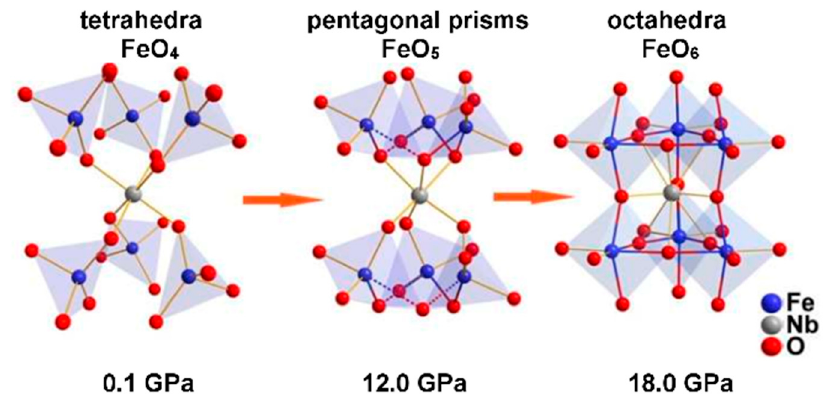
Figure 9. Structural fragments from Fe-O polyhedra of polymorph modifications of Ba 3 NbFe 3 Si 2 O 14 stable at different pressures. The transformation of the Fe 3+ coordination from tetrahedral to octahedral through the trigonal bipyramid under pressure is shown.